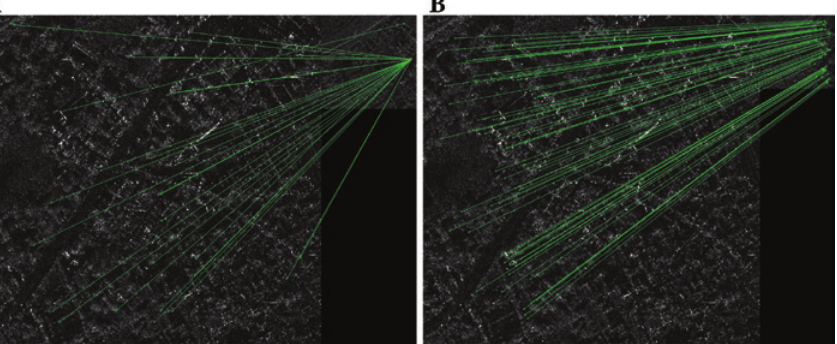
Figure 4: Comparison of the Proposed Two-Way Nearest-Neighbour Ratio Matching Strategy Using (A) Bhattacharya Distance and the (B) Standard First to Second NNR Matching